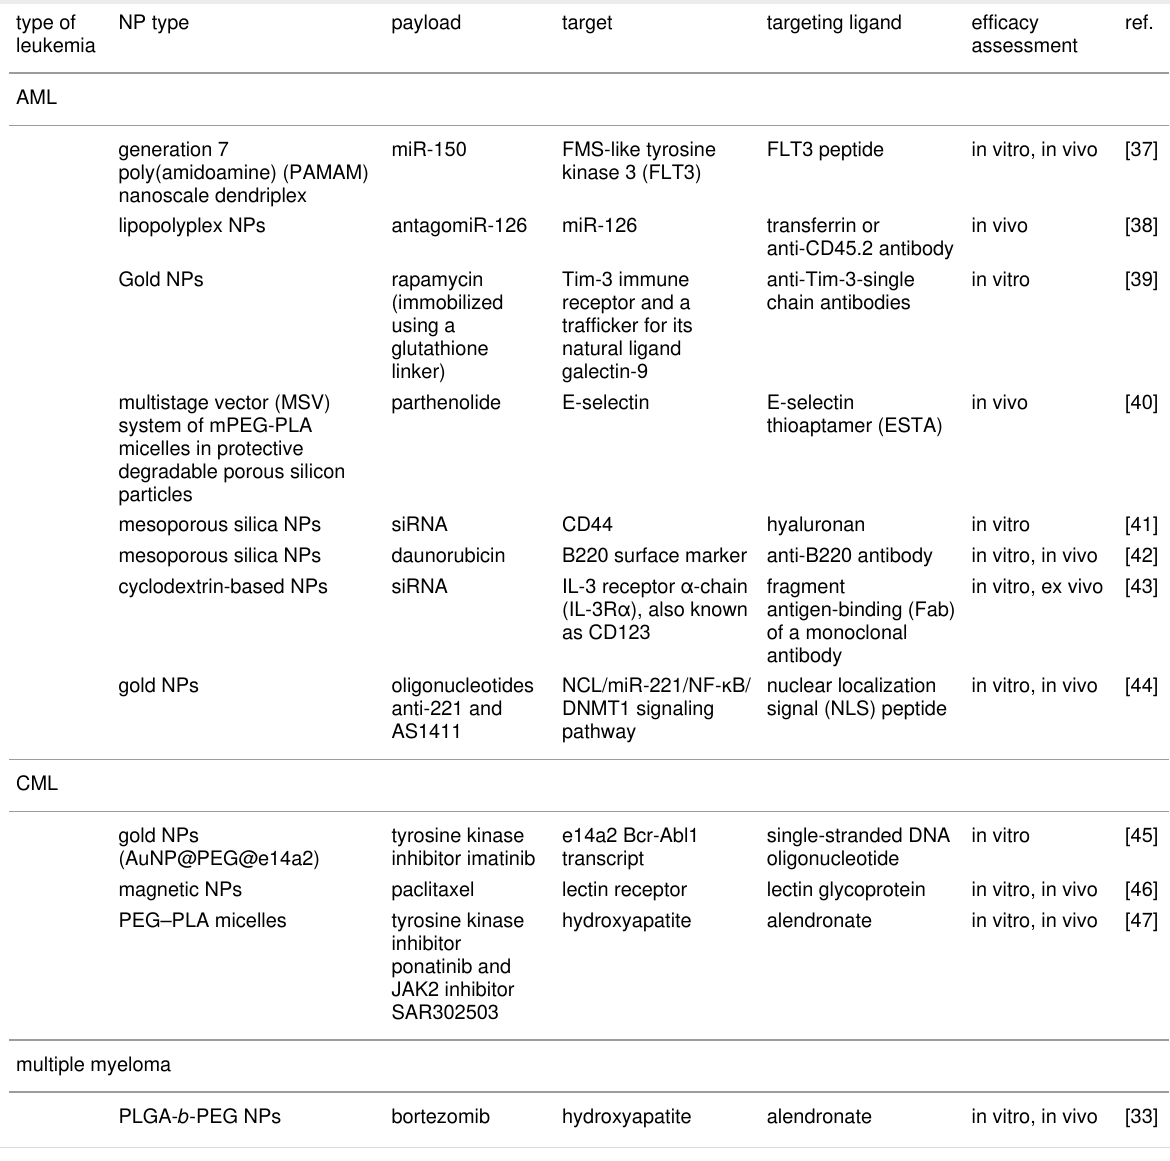
Table 1: NDDSs in molecular targeting of myeloid